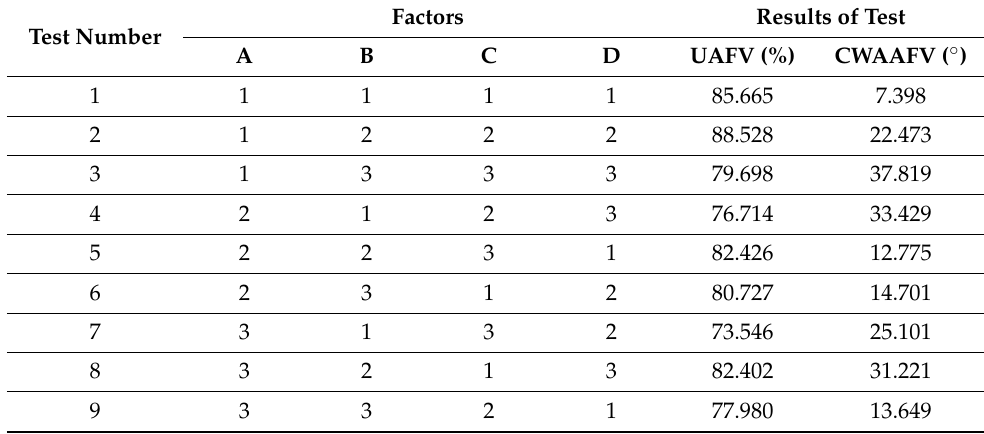
Table 2. Orthogonal test results.